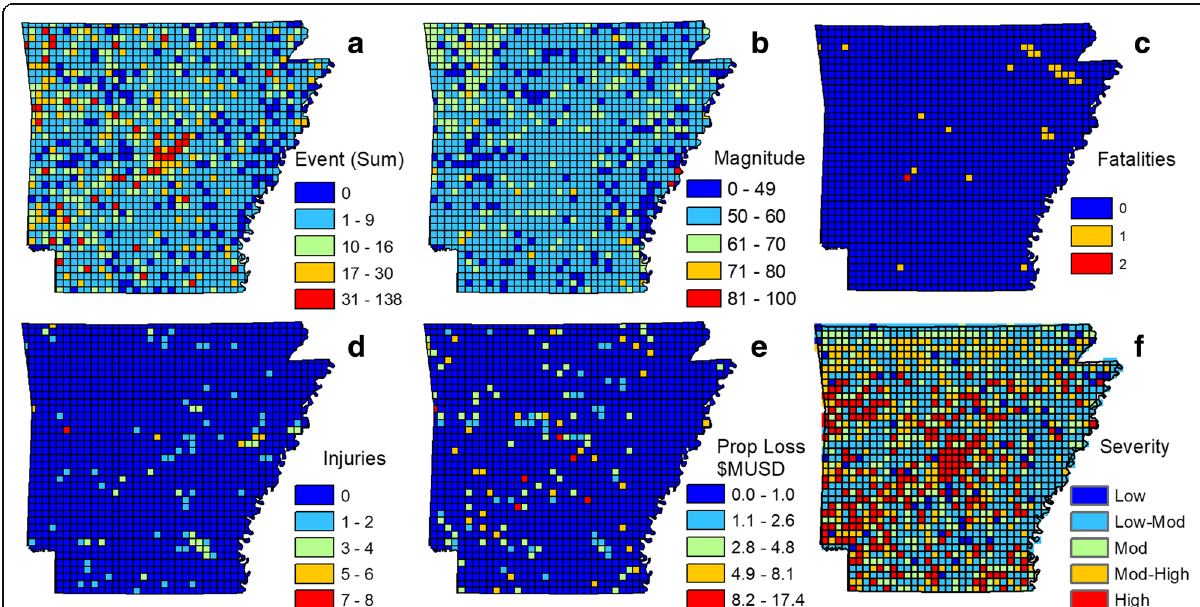
Fig. 8 Derecho damage (grid cell = 10 × 10 km): a Sum of all events b Derecho magnitude (0 – 100 knots) c Fatalities d Injuries e Property damage